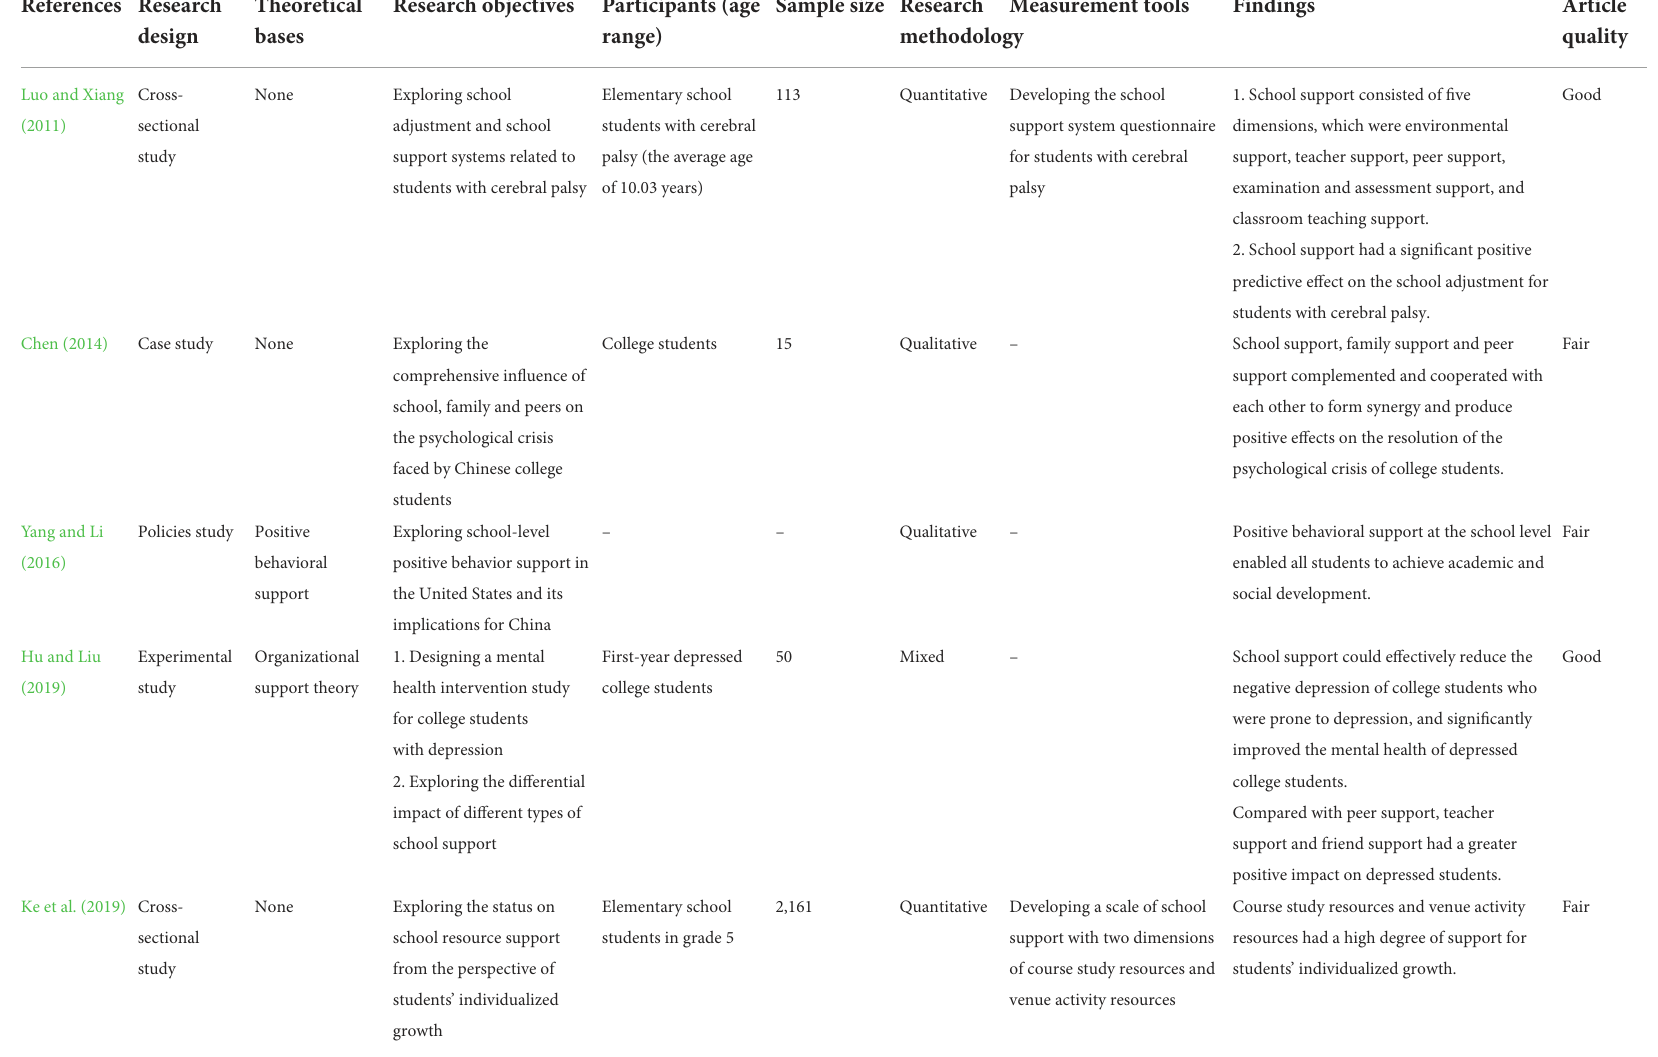
TABLE 3 Summary of included Chinese core-journal articles ( n =